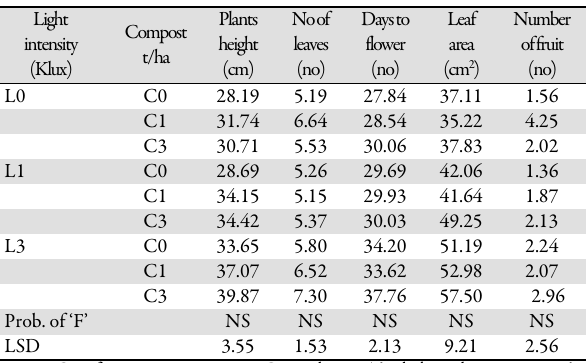
Table 7. Effect of light intensity on the vegetative growth of okra on the field Light Plant intensity height (klux)